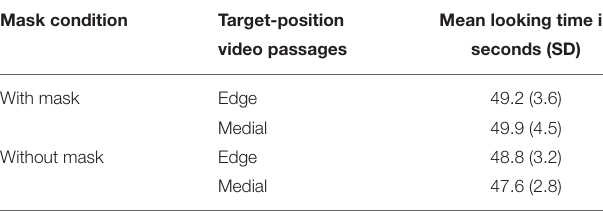
TABLE 3 | Mean-looking times for the familiarization phase in the audiovisual